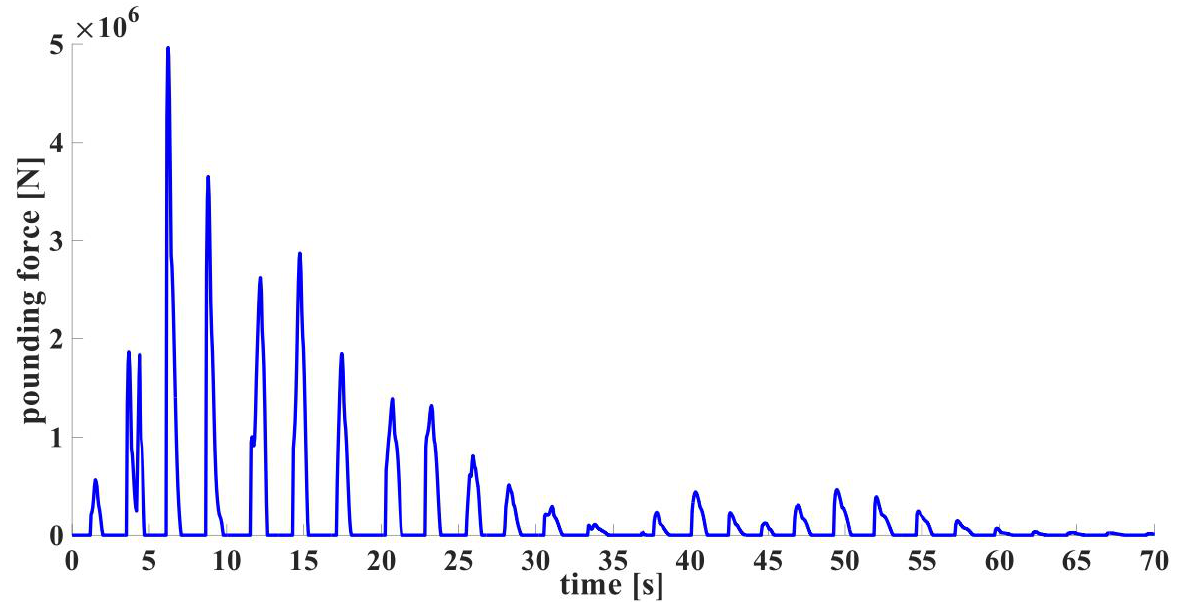
Figure 24. The pounding force under El-Centro earthquake excitation.